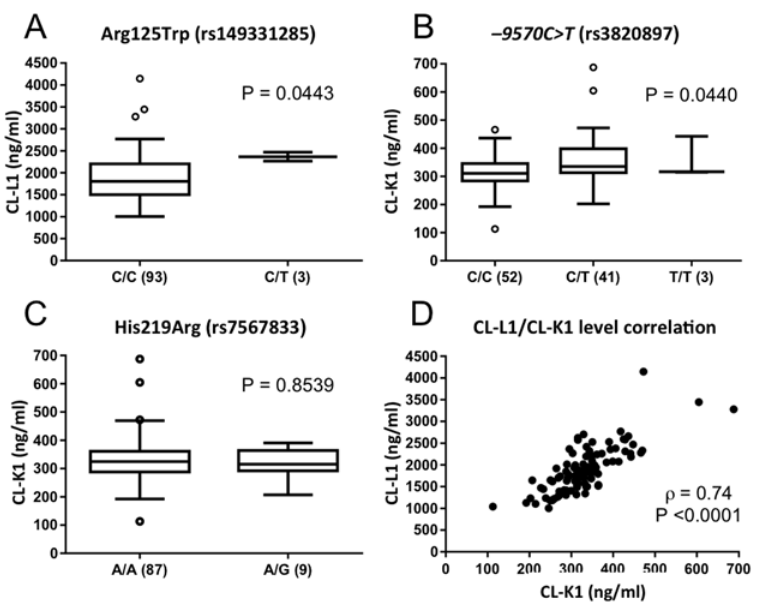
Fig 3. Impact of allelic variants on serum levels. A-C, the serum levels of CL-L1 and CL-K1 and the corresponding genotype. Horizontal bars indicate median values; number in parenthesis, number of individuals and white circles, outliers. Statistical significance was determined by non-parametric Mann- Whitney and Kruskal-Wallis tests. D, the distribution of CL-L1 and CL-K1 levels in the cohort. The strength of the correlation was calculated using Spearman